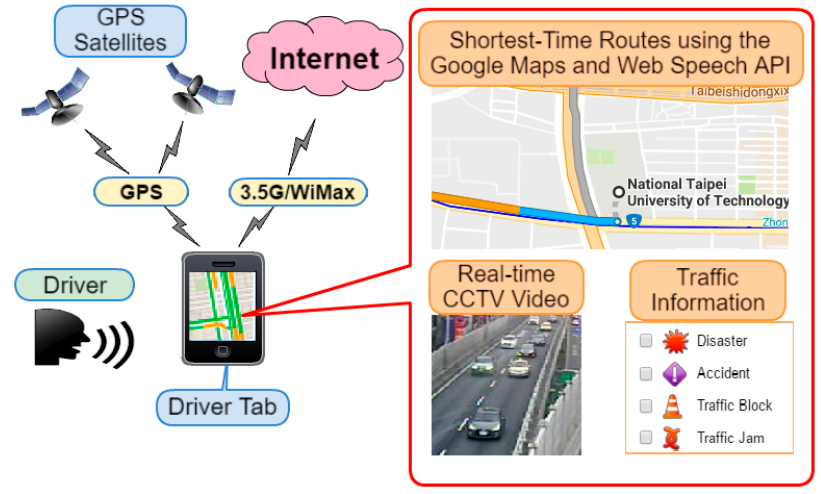
Figure 4. Traffic guiding subsystem. The driver tab is embedded with the GPS and a 3.5 G modem and a microphone.